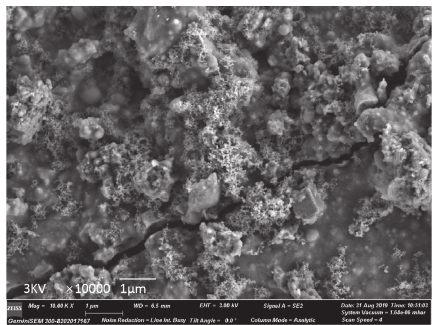
Figure 8: SEM micrograph showing the morphology specimen b4 at 10000x magnification.